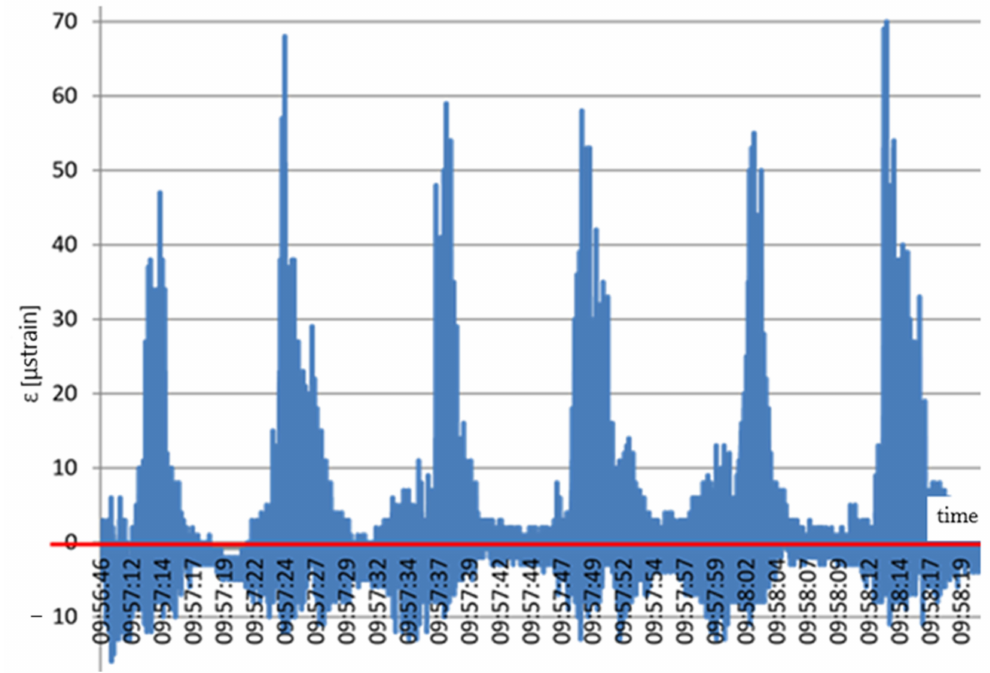
Figure 9. Scheme geogrid strains arising due to the interaction between the subsoil and the aggregate compaction process: x (s); y ( µ